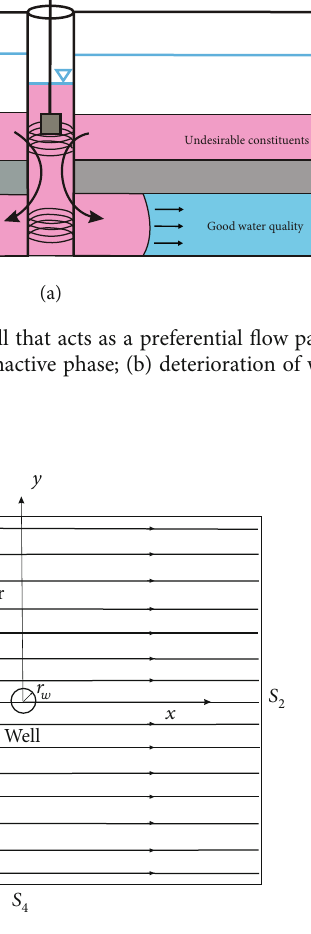
, S , S , and 1 2 3 and S are constant-head 1 2